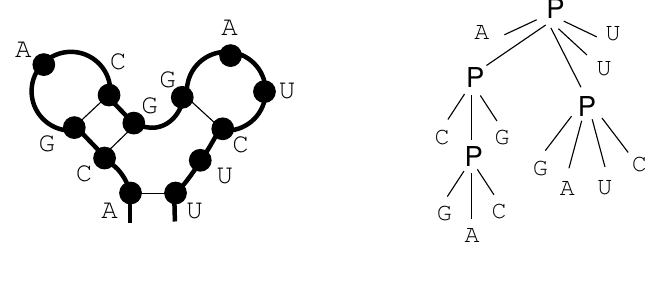
Figure 12. Structure representation where a P -node indicates a base pair bond between its left- and rightmost child, while the other subtrees represent structures enclosed by this base pair. In this representation, the left- or rightmost child of a P -node can never be another P -node, while the other children